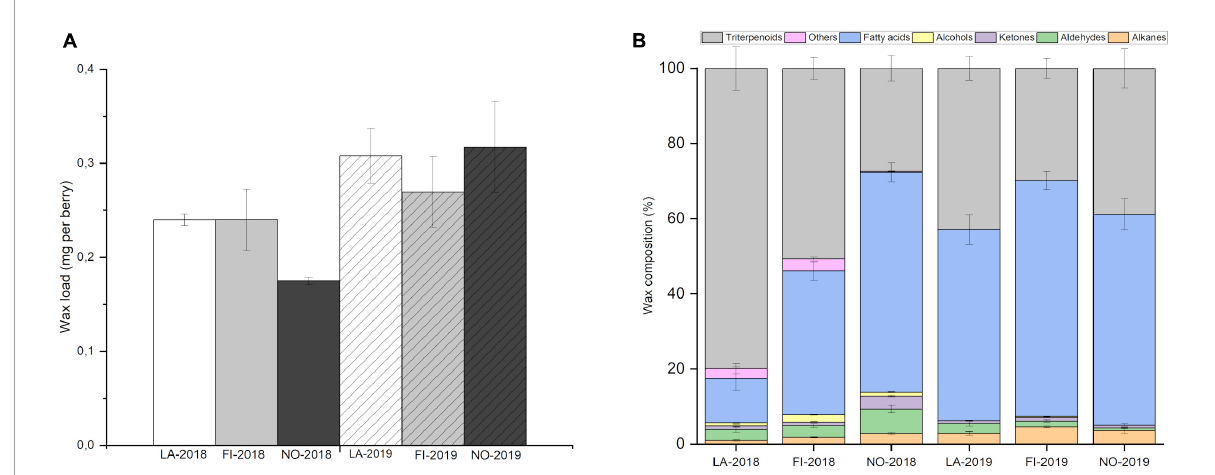
FIGURE1 Cuticular wax load and profile through latitudinal gradient. (A) Amount of cuticular wax (mg per berry) in bilberry fruits from Latvia (LA), Finland (FI), and Norway (NO) in years 2018 and 2019. The data is shown as mean ± SD of five replicates. (B) Cuticular wax profile in bilberry fruit through a latitudinal gradient from LA through FI and NO in 2018 and 2019. Error bars indicate Standard Error ( n = 5).